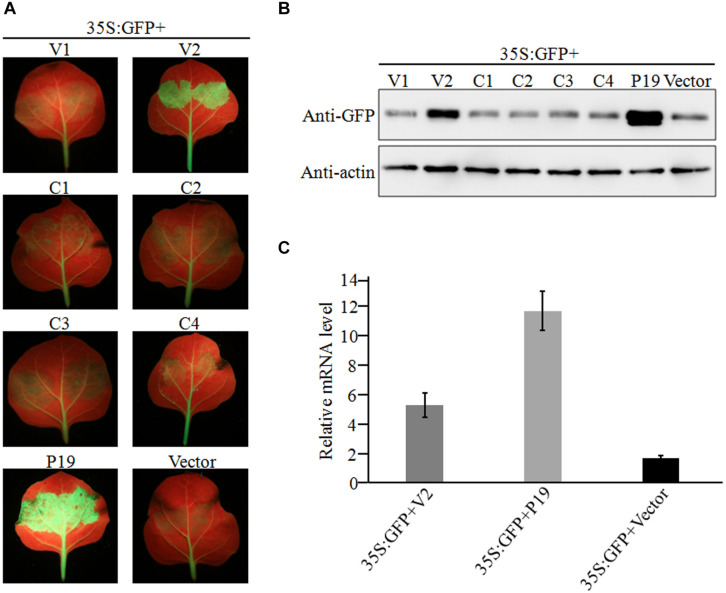
Suppression of local GFP silencing in 16C transgenic plant by GGVA V2 protein. (A) 35S:V1, 35S:V2, 35S:C1, 35S:C2, 35S:C3, 35S:C4, 35S:P19 (positive control) and empty vector pCHF3 (negative control) were co-infiltrated into N. benthamiana 16C plants with 35S-GFP, respectively. Fluorescence was observed and photographed under UV lamp at 7 dpi. (B) Western blotting analysis of GFP protein extracted from agroinfiltrated patches of 16C leaves shown in (A) using a GFP monoclonal antibody. Actin was used as internal reference. (C) A qRT-PCR assay was used to analyze the transcription level of GFP extracted from agroinfiltrated patches of 16C leaves shown in (A). GADHP was used as the internal reference gene.